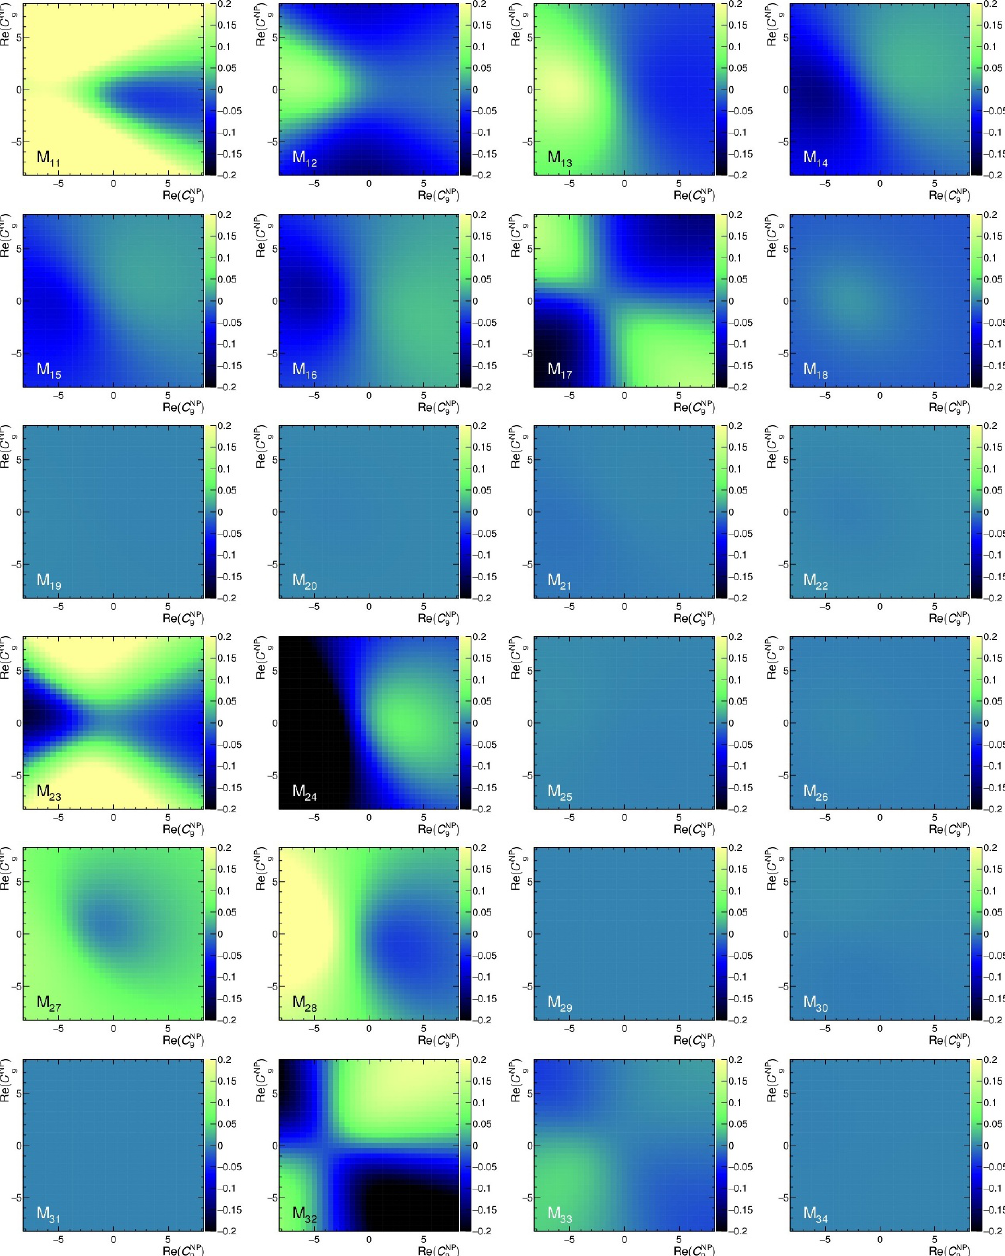
+ (cid:22) (cid:0) decay b ! (cid:3) (cid:22) = 1 is used. b